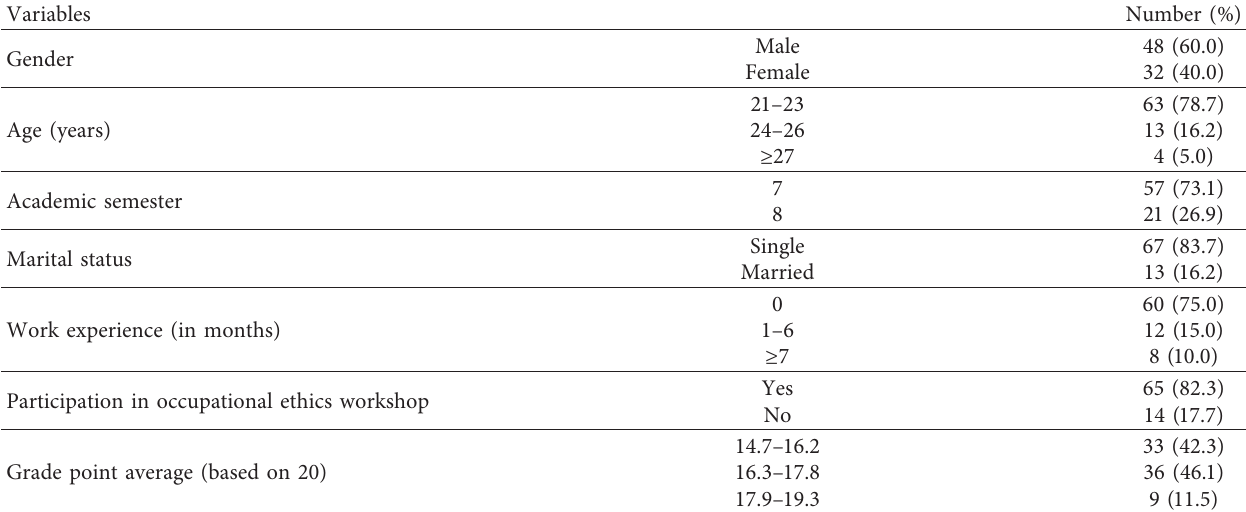
Table 1: Demographic characteristics of participants.